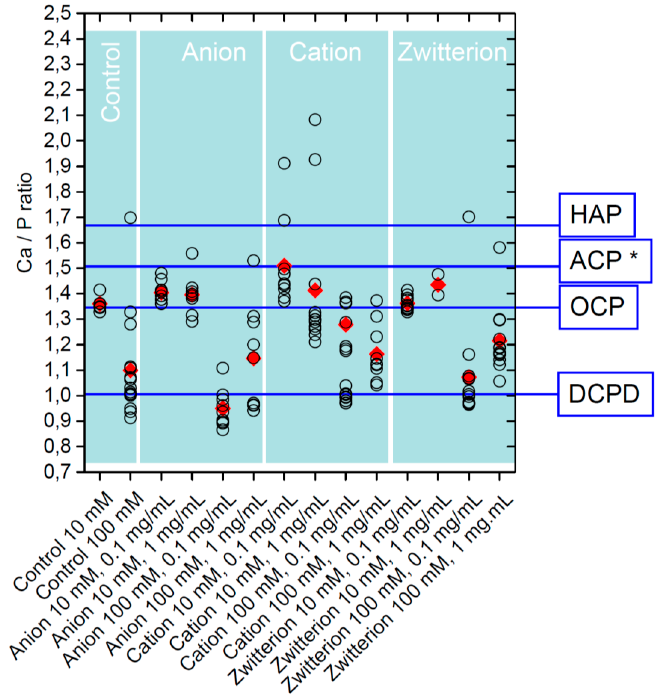
Figure 5. Calcium phosphate ratios determined from EDXS measurements. Red symbols are average values determined from at least five measurements, open black circles are Ca/P ratios obtained from individual measurements taken at different spots on different samples prepared with the identical procedure, respectively. Horizontal blue lines are the Ca/P ratios for the different calcium phosphate phases specified at the respective line. * Note that for ACP, the Ca/P ratios in the literature vary from ca. 1.20 to 2.20 [59,60].